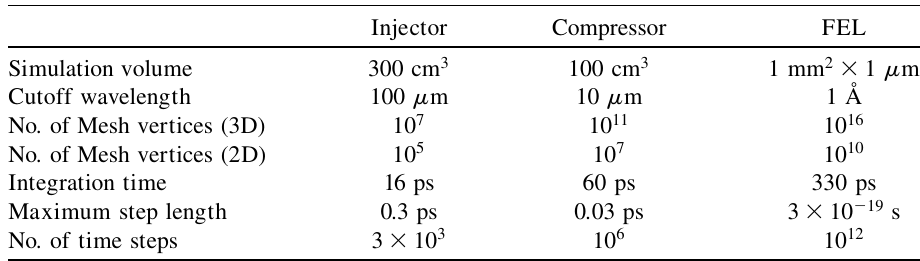
TABLE I. Typical mesh sizes for the simulation of the beam dynamics at the injection, compression, and FEL stages with PIC techniques.